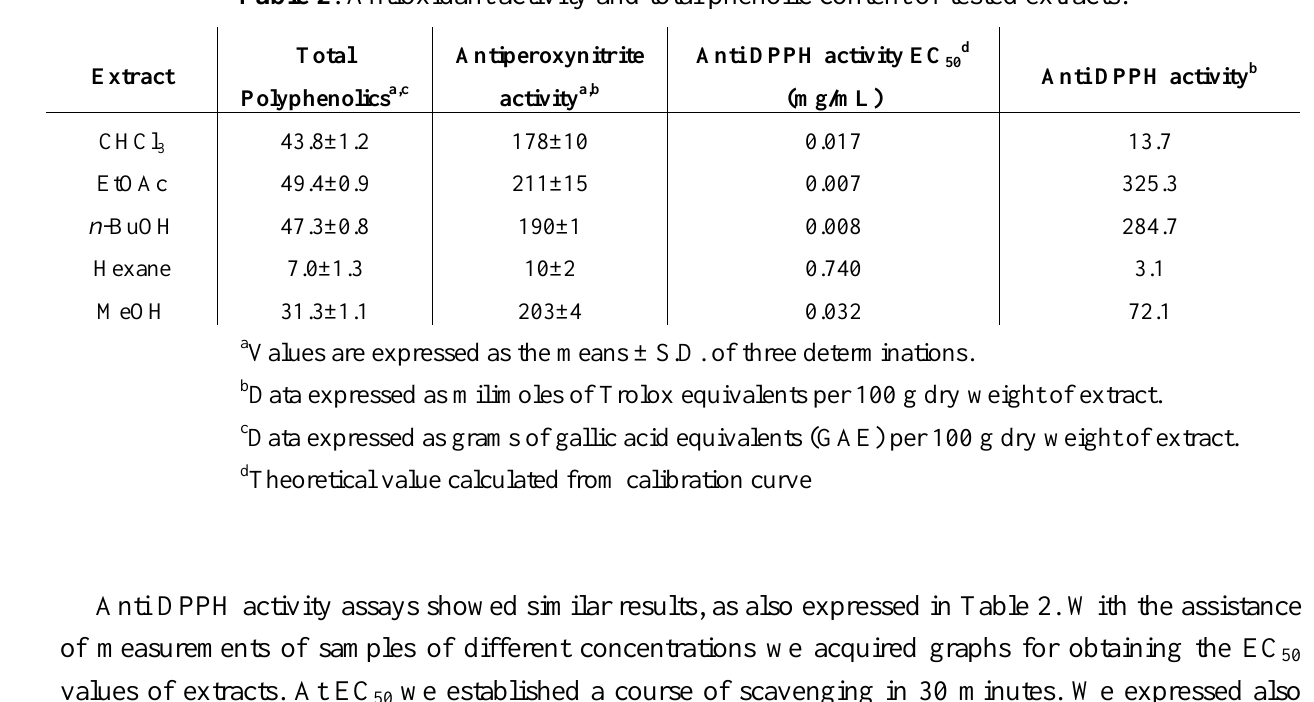
Table 2 : Antioxidant activity and total phenolic content of tested extracts.